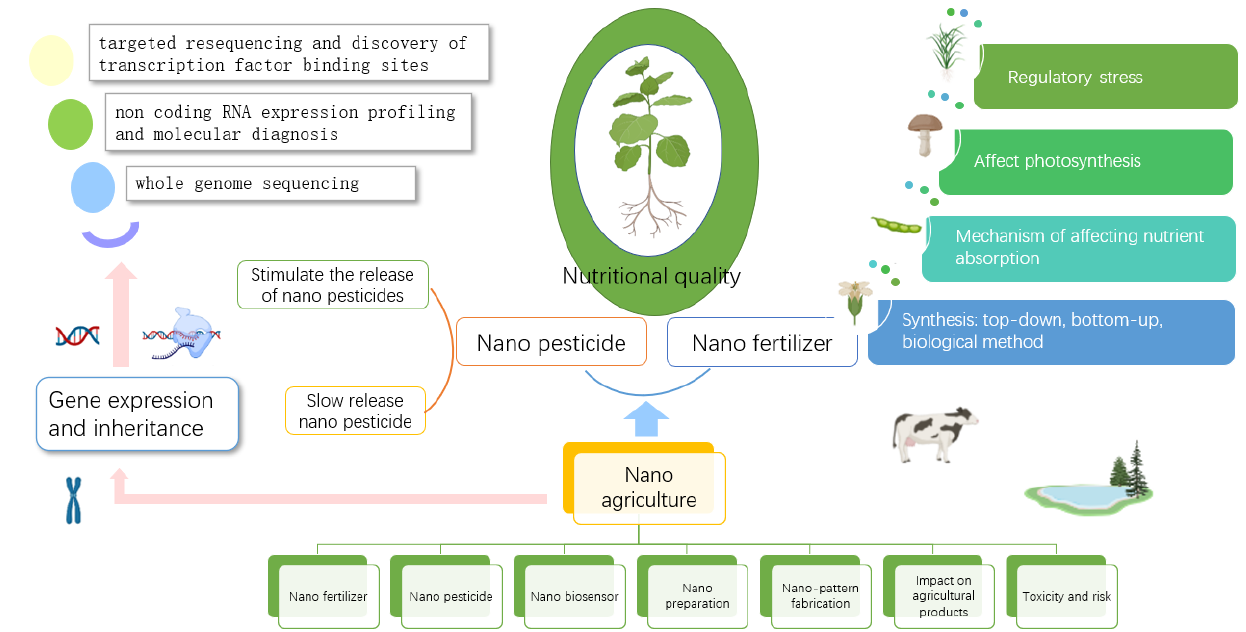
Figure 2. Schematic diagram of nano-agriculture, mainly to improve the nutritional quality of agricultural products by improving crop genes, nano pesticides, and nano fertilizers.